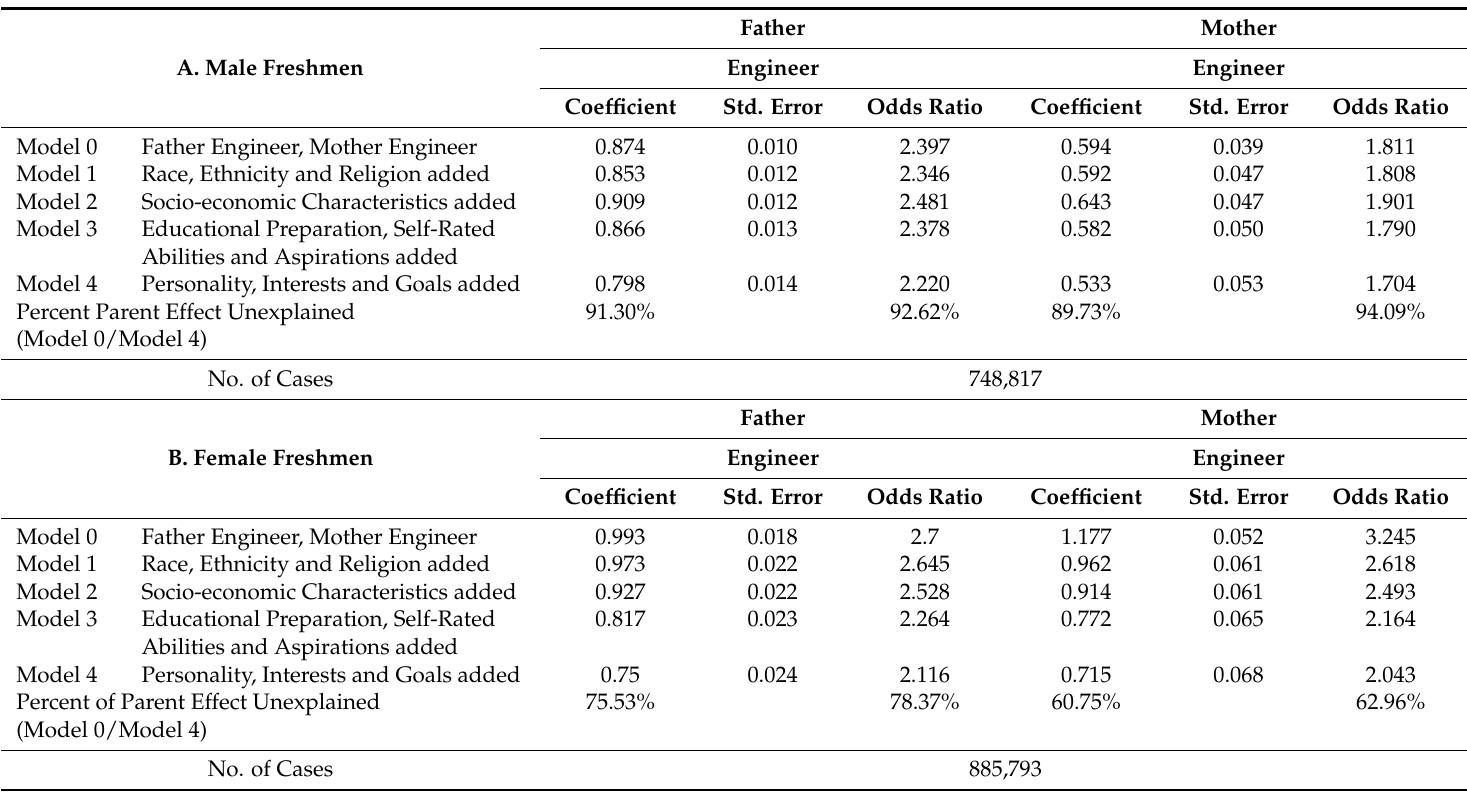
Table 3. Summary of Logistic Regression